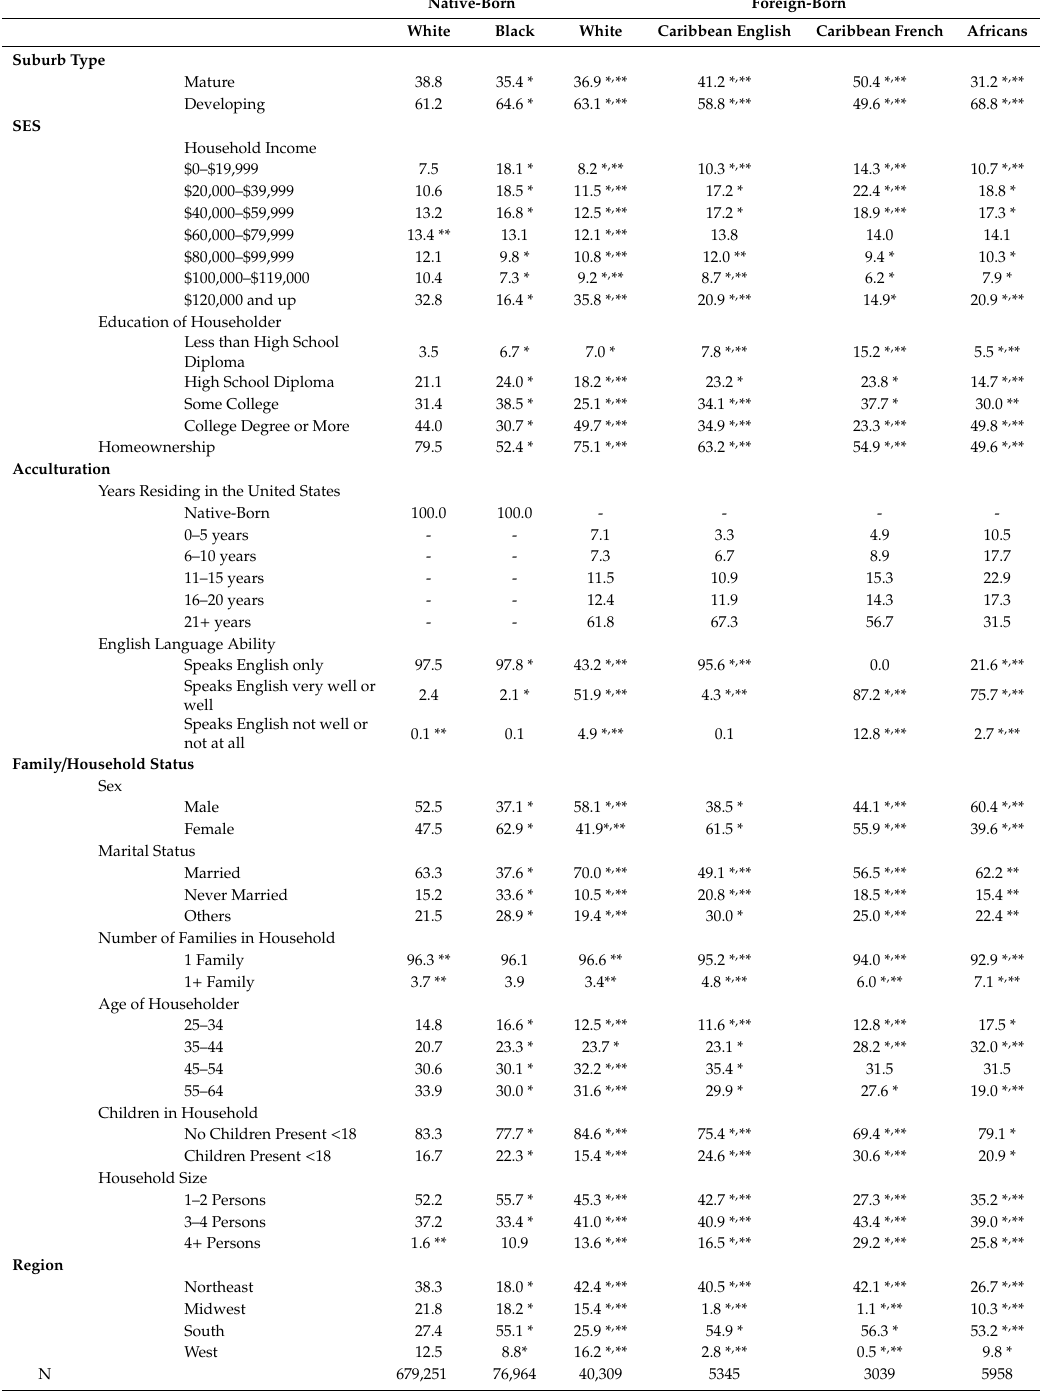
Table 1. Percentage di ff erences by race / ethnicity and nativity status / place of birth. Native-Born Foreign-Born White Black White Caribbean English Caribbean French